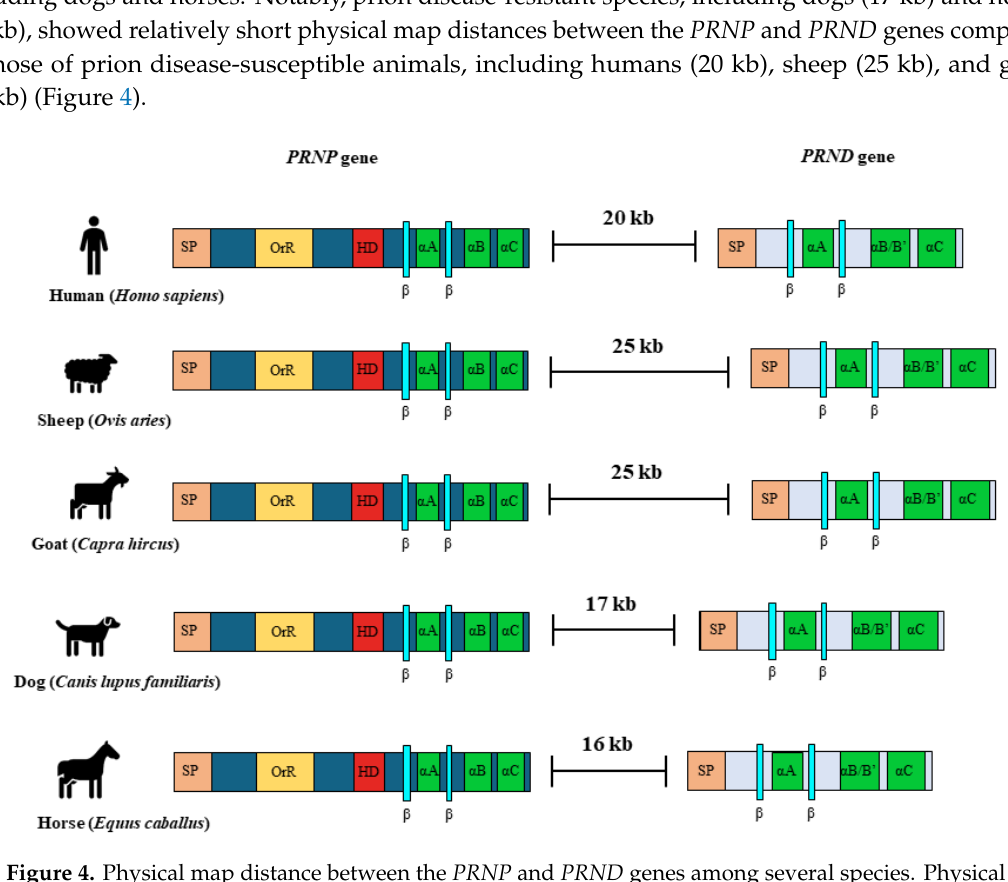
Figure 4. Physical map distance between the PRNP and PRND genes among several species. Physical map distances between the PRNP and PRND genes among several species were visualized in prion disease-resistant species, including dogs ( Canis lupus familiaris ) and horses ( Equus caballus ), and prion disease-susceptible species, including humans ( Homo sapiens ), sheep ( Ovis aries ), and goats ( Capra hircus ). SP: Signal peptide; OrR: Octapeptide repeat; HD: Hydrophobic region.